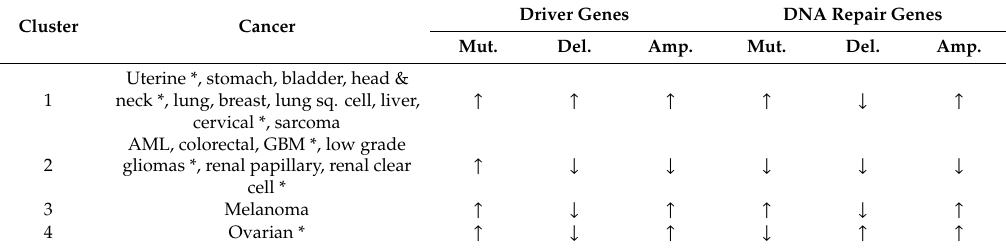
Table 5. Qualitative patterns of genomic event rates per gene-tumor for each cluster identified during hierarchical cluster analysis (from Figure 3). Opportunistic cancers for further study in cluster 2 are AML, colorectal, and renal